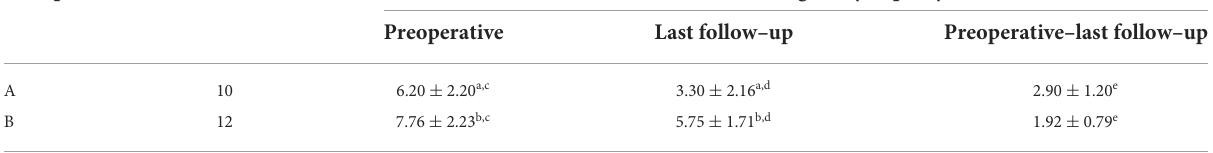
TABLE 4 Aminoff–Logue scores before and after